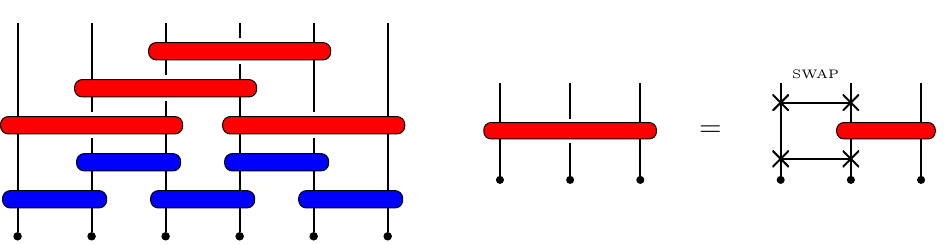
Figure 3: Left: The blue brickwall layer encodes the first-order Trotter decomposition for NN interacting Hamiltonians. The combination of the blue and red layers encodes the first-order Trotter decomposition for NNN interacting Hamiltonians, where the blue gates act on NN qubits whereas the red gates act on NNN qubits. Right: The decomposition involving SWAP gates, displayed as the crossed line, which is used to convert the NNN two-qubit gate into a circuit involving only two-qubit